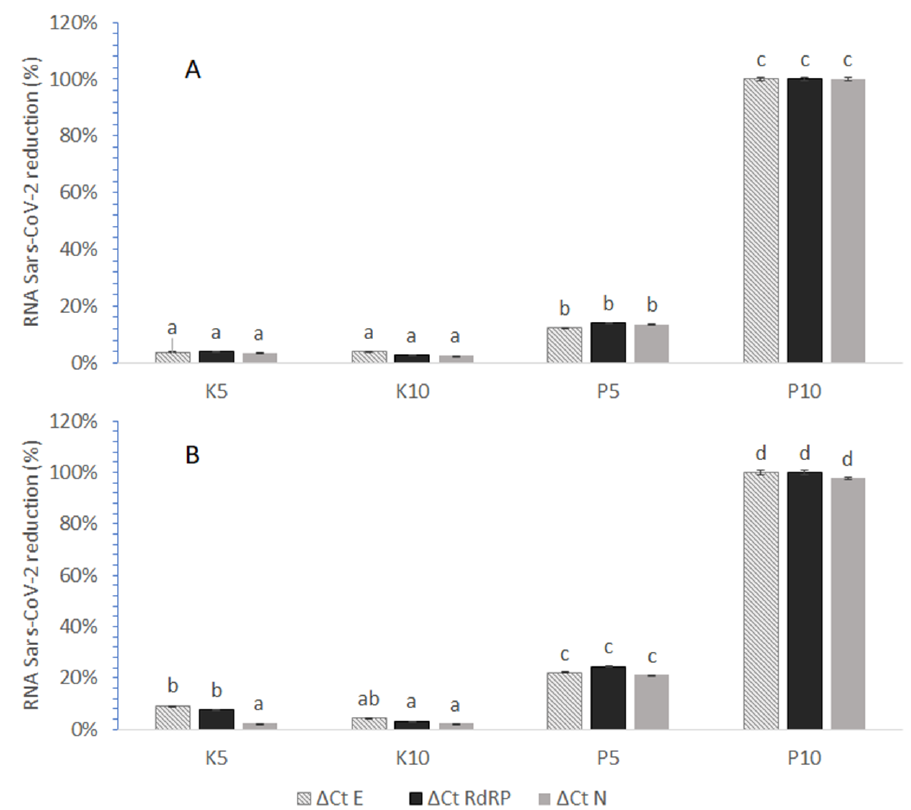
Figure 5. Percent reduction in SARS-CoV-2 RNA in terms of the three sequence targets investigated (E, RdRP, and N, represented respectively as light gray, black, and dark gray bars) in PP ( A ) and PET ( B ) samples treated for 5 (P5) and 10 min (P10), compared with their positive controls (K5 and K10). Different letters indicate significant differences among values related to the same packaging